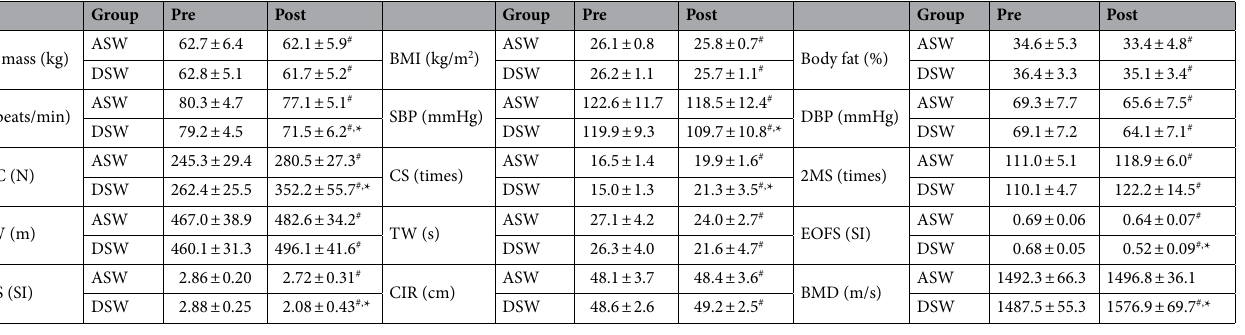
Table 1. Changes (mean ± SD) between the pre- and post-training time points in the ascending (ASW; n = 15) and descending stair walking (DSW; n = 15) groups for body mass, body mass index (BMI), percent body fat, resting heart rate (HR), systolic (SBP) and diastolic blood pressure (DBP), maximal voluntary isometric contraction strength of the knee extensors (MVIC), performance in the 30-s chair stand (CS), 2-min step (2MS), 6-m walk (6 MW), 6-m tendon walk (TW) test, balance with eyes open on firm surface (EOFS), balance with eyes closed on unstable surface (ECUS), upper thigh circumference (CIR), and bone mineral density (BMD). # : significant ( p ≤ 0.05) difference compared with the pre-training level. *: significant ( p ≤ 0.05) difference compared with the ASW group.